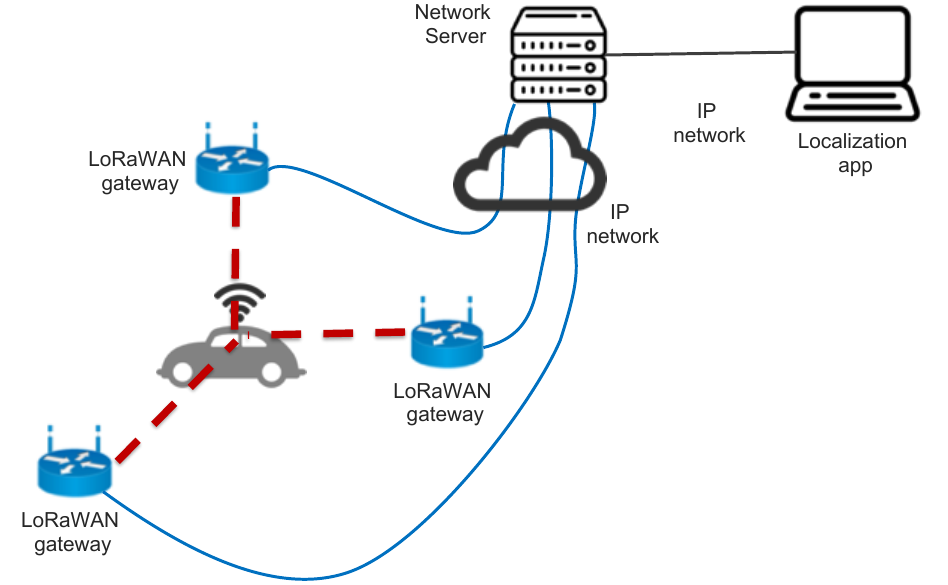
Figure 2. The architecture of the proposed